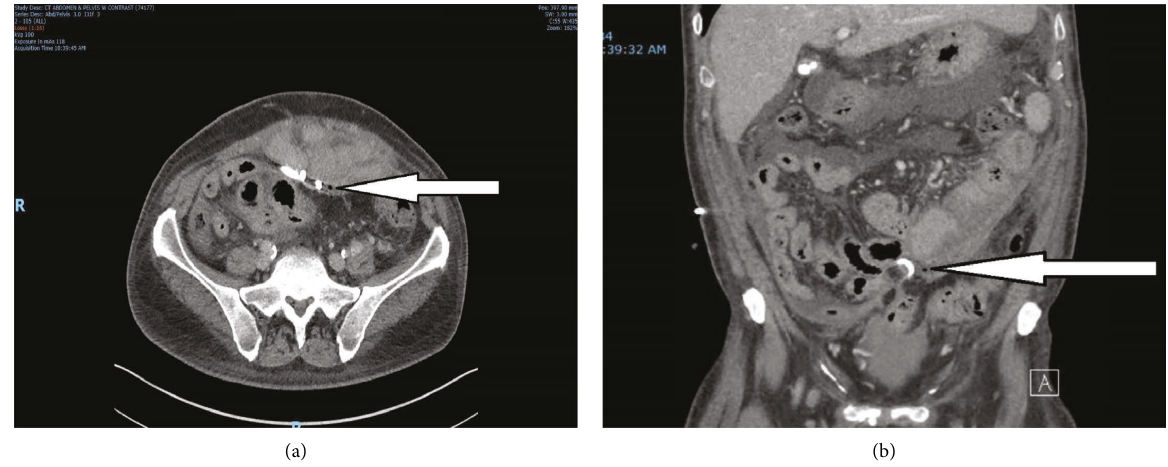
Figure 2: (a) Computed tomography (CT) abdomen/pelvis cross sectional view showing near complete resolution of the previously large intraabdominal abscess with small amount of air visible along the track of the drain catheter (solid white arrow). (b) Computed tomography (CT) abdomen/pelvis coronal view showing near complete resolution of the previously large intraabdominal abscess with air visible along the track of the drain catheter (solid white arrow).